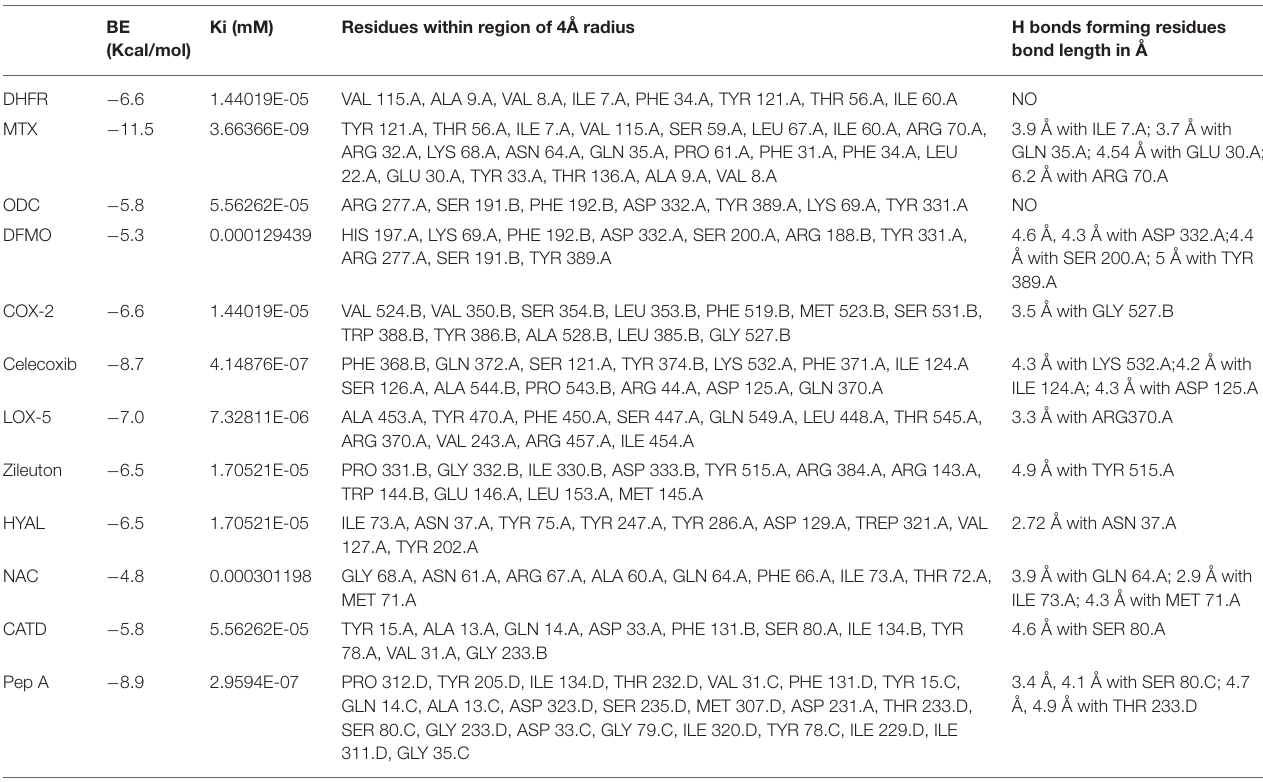
TABLE 3 | Molecular docking interaction of carvacrol with different cancer targets. BE Ki (mM) Residues within region of 4Å (Kcal/mol)